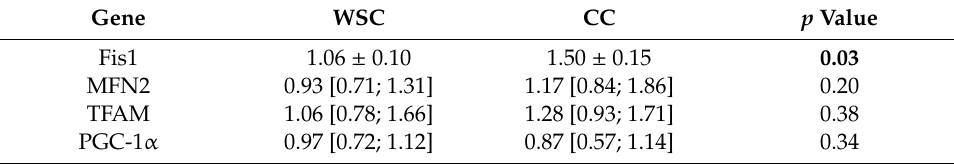
Table 2. Skeletal muscle gene expression of mitochondrial regulation genes in WSC and CC. Gene